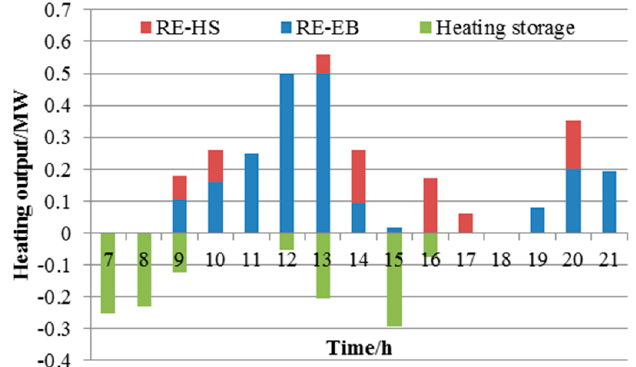
Figure 12. Scheduling results of regenerative electric (RE) operation for Case 3 .